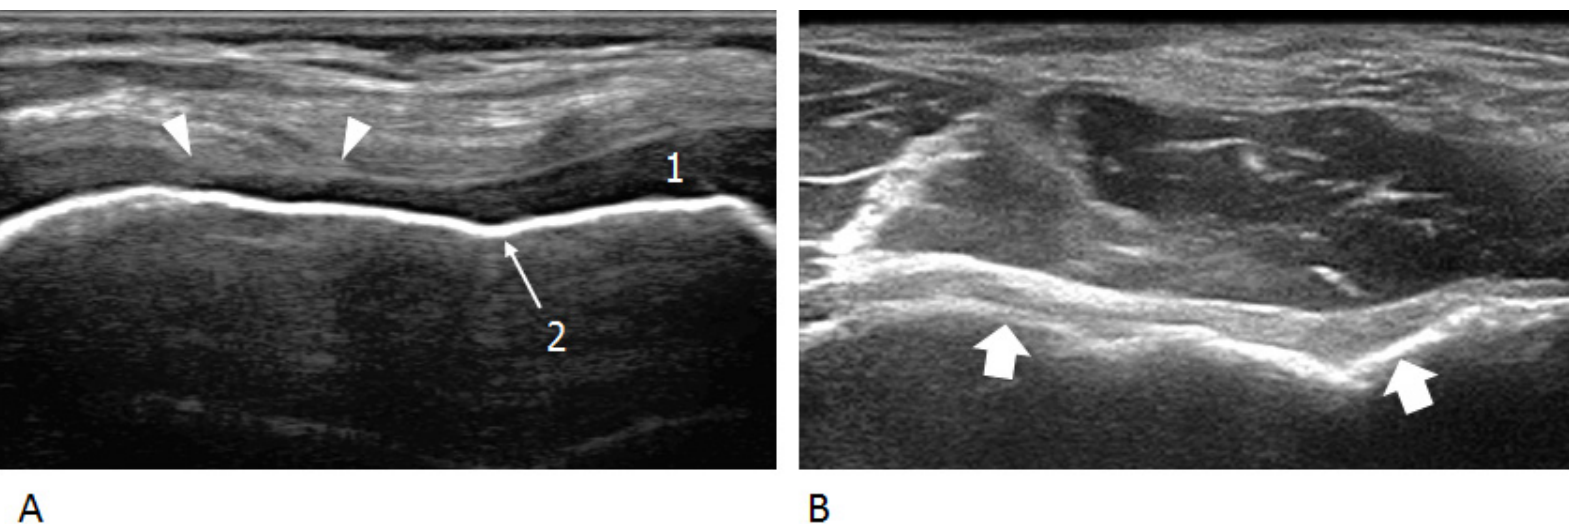
Figure 2. Osteochondral abnormalities. ( A ) Early damage. Transverse US image over the anterior ankle reveals focal partial-thickness loss (arrowheads) of the cartilage (1) investing the talar dome. The subchondral bone (2) retains a normal appearance. ( B ) Advanced damage. Transverse US image over the anterior aspect of the distal humeral epiphysis demonstrates complete loss of the articular cartilage and mild irregularities of the subchondral bone (arrows).